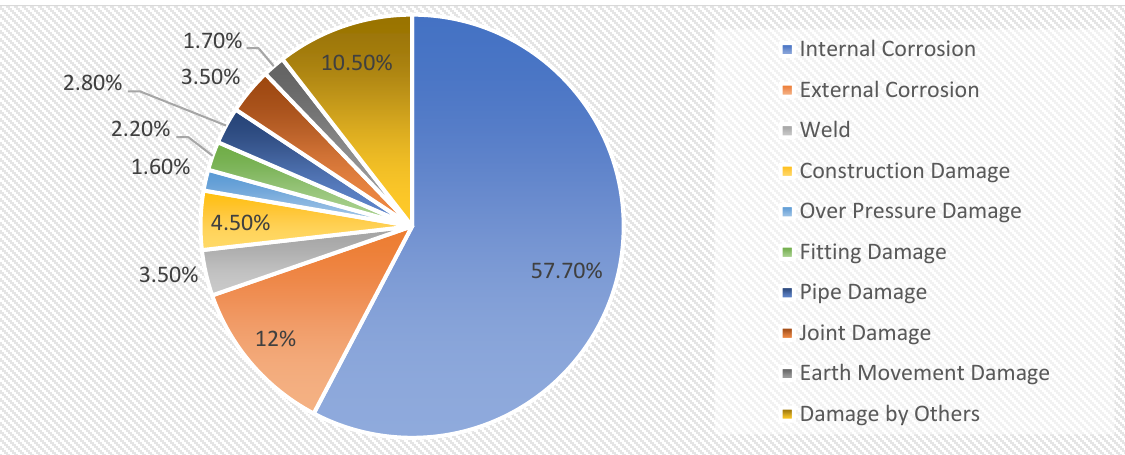
Figure 1. The percentages of several causes of production pipeline failure based on the report in [5].